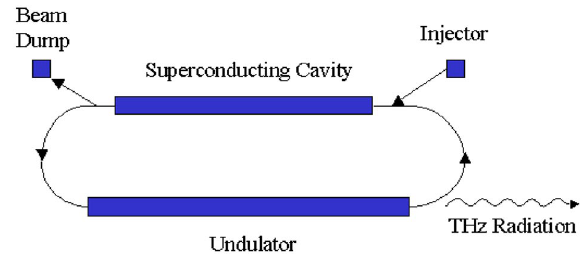
FIG. 1. (Color) Compact high average power THz source. The undulator is 1.25 m long in the case considered.